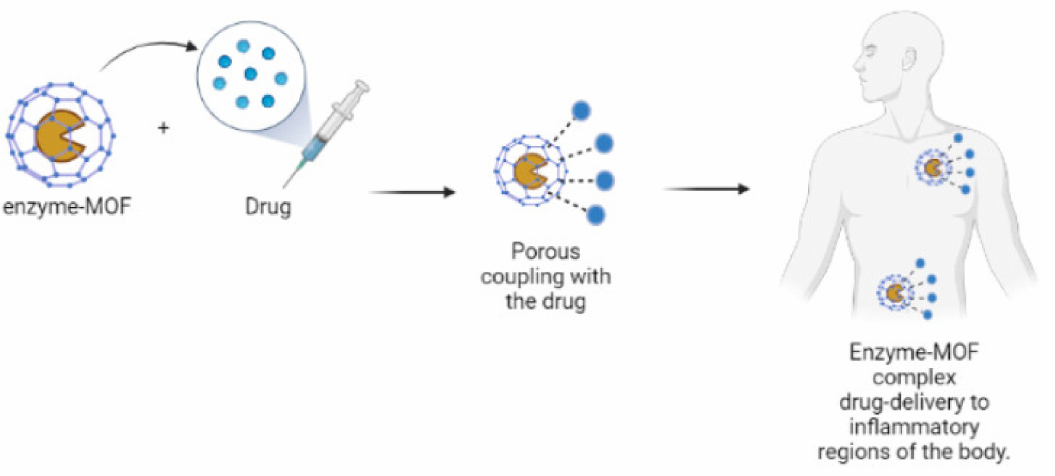
Figure 9. Enzyme–MOF composites carrying drugs in the pores of the immobilization support through the body, which can be a useful tool in the treatment of diseases in different parts of the